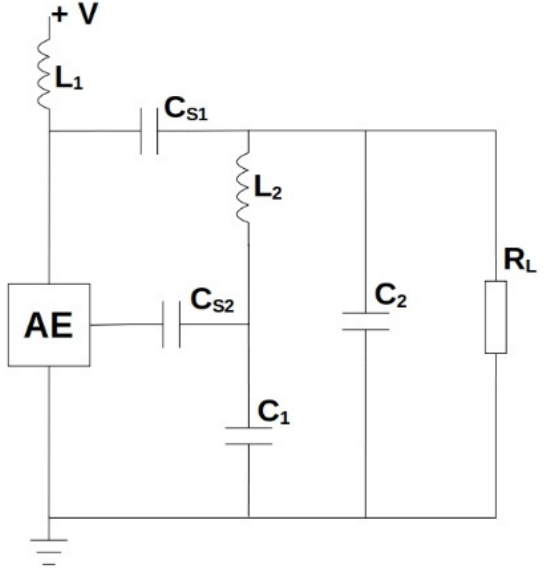
Figure 1. Principal scheme of the Colpitts oscillator.